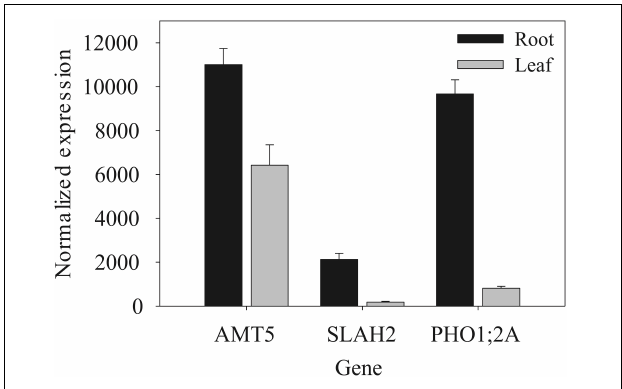
FIGURE 8 | Gene expression in root and shoot organs among nutrient transport candidate genes. Data (mean ± SD) are for V1-stage plants from Sekhon et al.